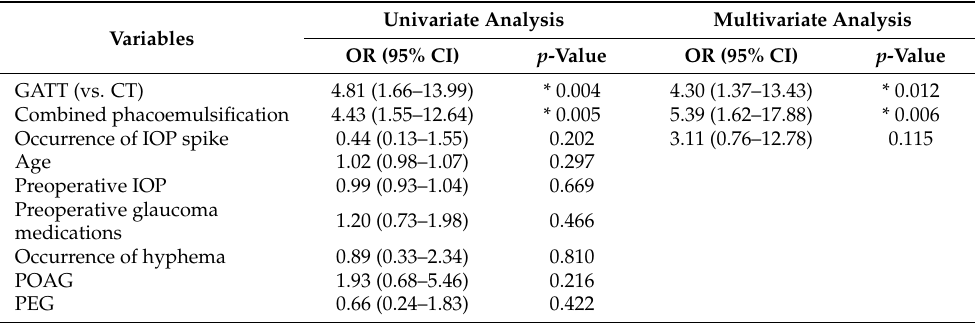
Table 5. Factors associated with the surgical success at 1 year